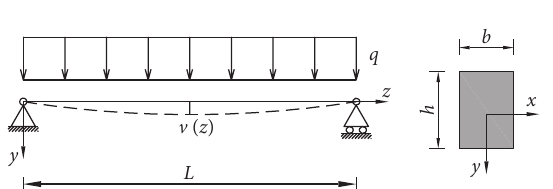
Figure 5: Problem formulation: simply supported beam with constant